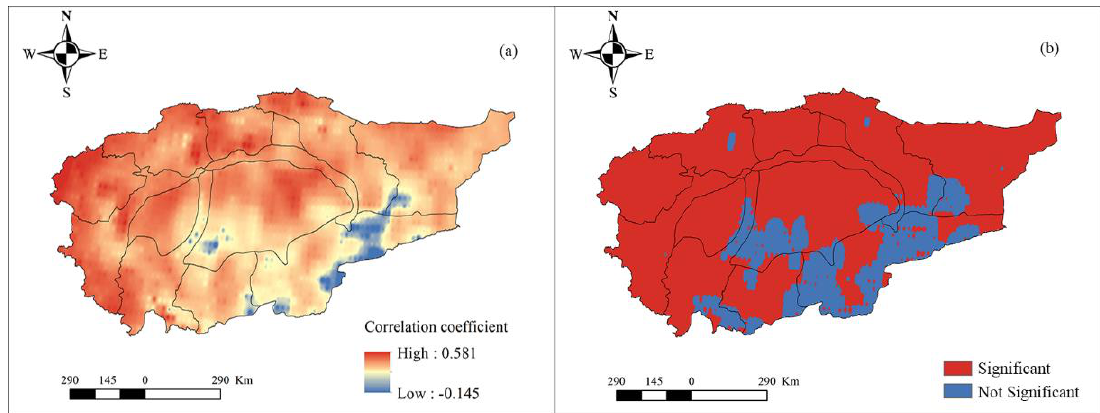
Figure 8. The correlation between SPI and SWSI on an inter-annual scale ( a ) and its significance ( b ).